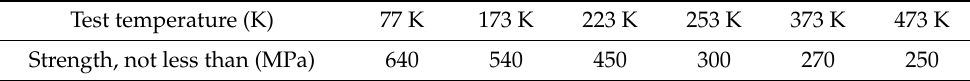
Table 1. Tensile strength characteristics of the joint at various temperatures. Test temperature (K) 77 K 173 K 223 K 253 K 373 K 473 K Strength, not less than (MPa) 640 540 450 300 270